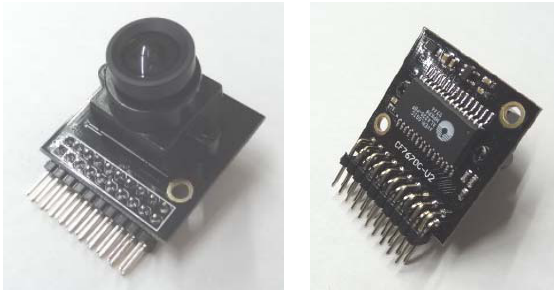
Figure 2. The camera module with the FIFO memory at the back.